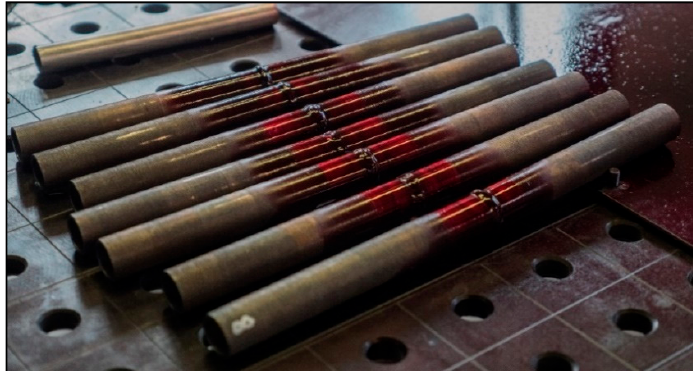
Figure 6. Application of detection liquid.